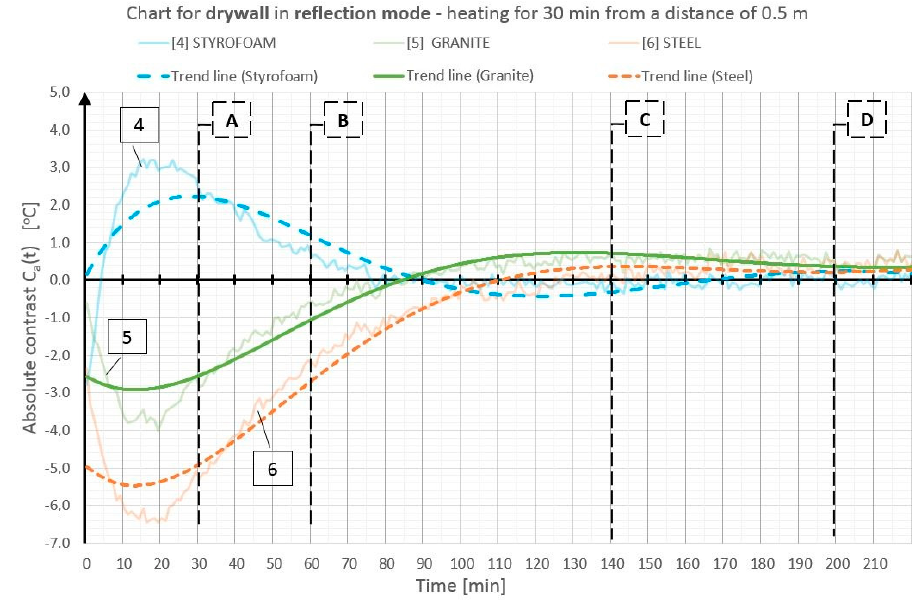
Figure 5. Diagram of absolute contrast for measuring the reflection mode for the GB partition model with heating from a distance of 0.5 m (based on thermograms in Figure 3, row II).